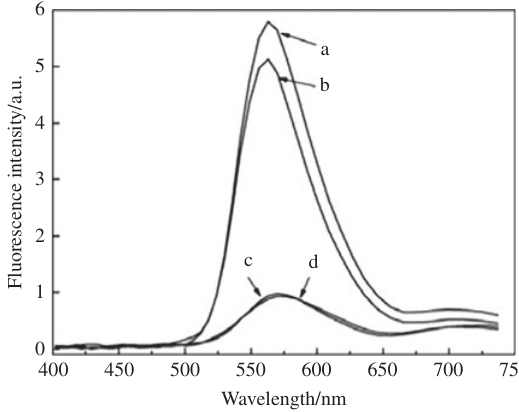
Fourier transform hyperspectral imaging analysis of a lemon leaf surface pretreated with rhodamine 6G crystals and con- taminated by a droplet of Romectin . Points a and b represent the spectra at the contaminated part, whereas points c and d represent clean sites ( Hake et al. 2007